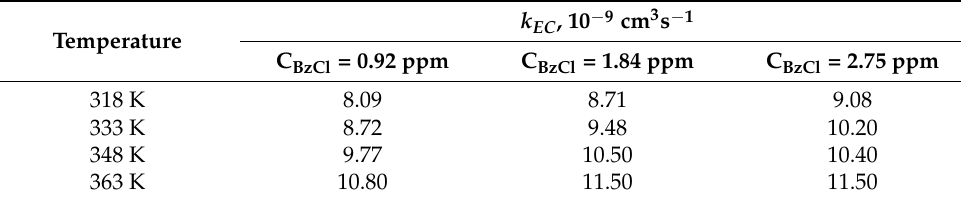
Figure 5. The drift time spectra measured for the introduction of the sample with drift gas ( a ) and the graph of the signal logarithm versus drift time used to determine the electron attachment rate constants ( b ). Table 2. Measured values of the electron attachment